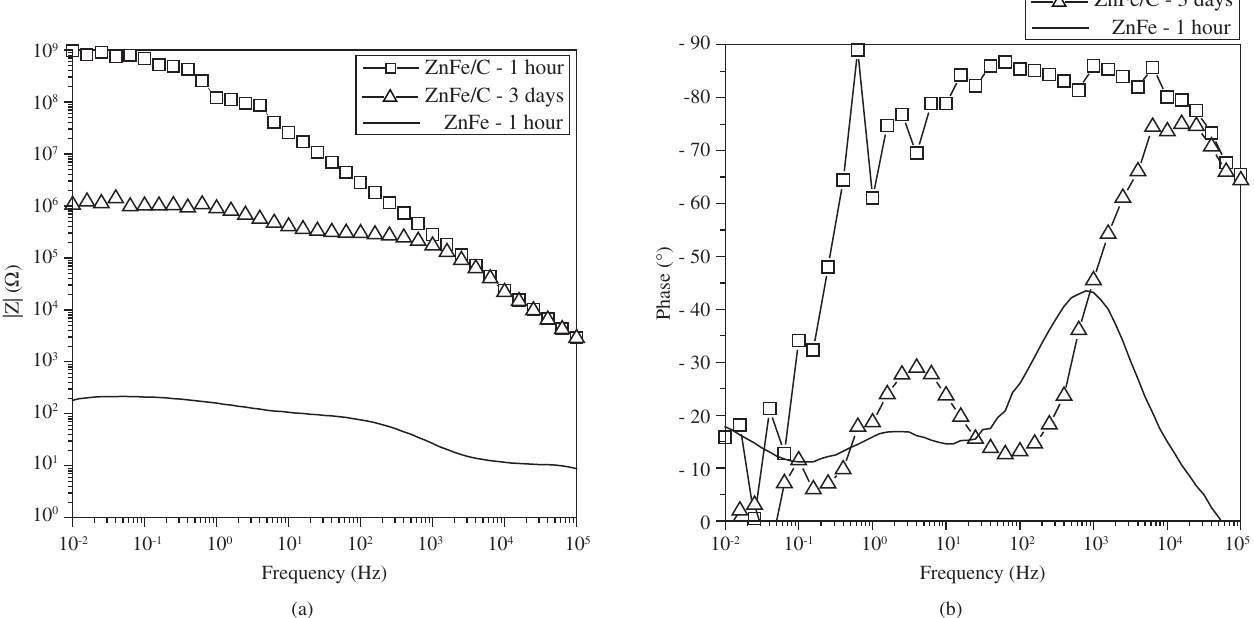
Figure 4. Representative Bode plots obtained in substrate ZnFe and coated ZnFe/C samples, after 1 hour and 3 days of immersion in 3% NaCl solution: a) Bode Z; and b) Bode